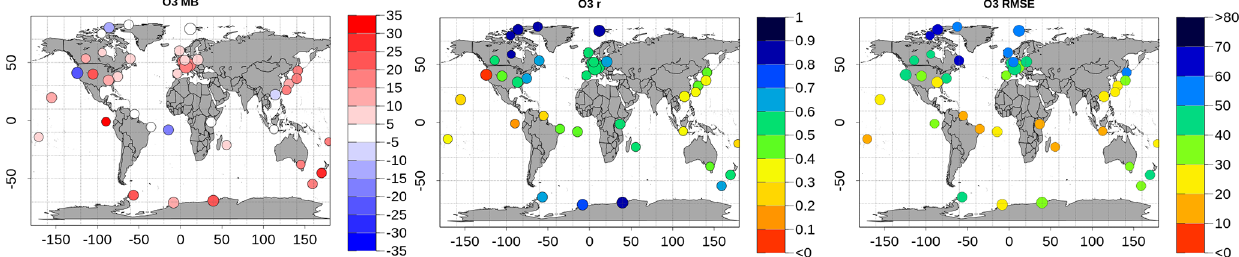
Figure 14. Mean tropospheric ozone bias spatial distribution (MB, ppb) (left panel), correlation (middle panel) and RMSE (ppb) (right panel) for year 2004, averaged between 400 and 1000hPa. The diameter of the circles indicates the number of profiles over the respective stations. The bias is calculated as model minus